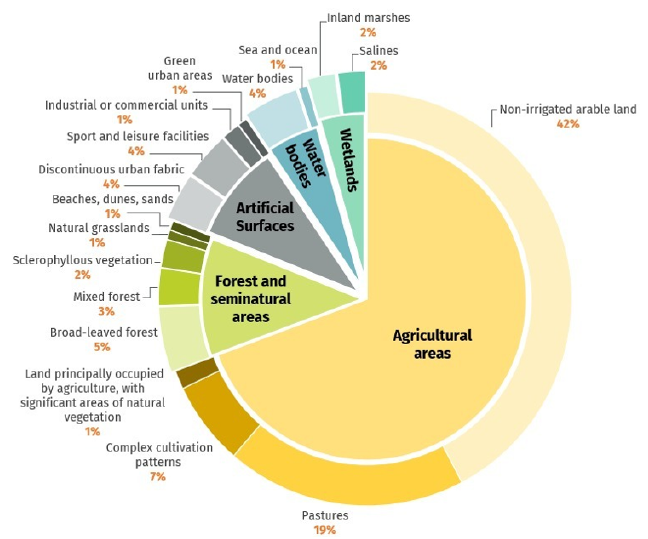
Figure 3. Frequency of land cover types with the occurring coastal ponds. Inner circle: level 1 Corine Land Cover classes. Outer ring: level 3 Corine Land Cover classes.